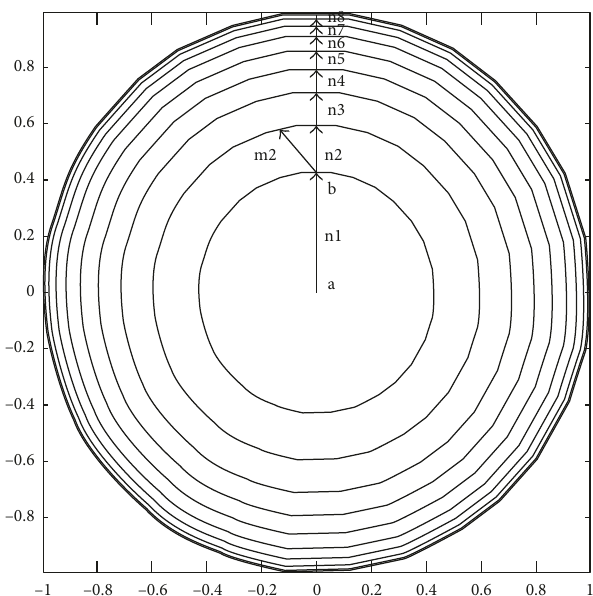
Figure 5: The contour lines of the hemisphere